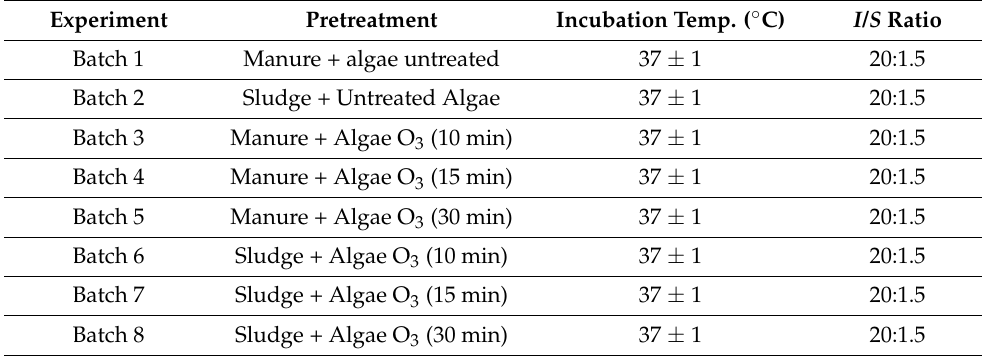
Table 1. Overview of substrates and pretreatment processes used for the estimation of the biogas yield of Ulva lactuca in batch